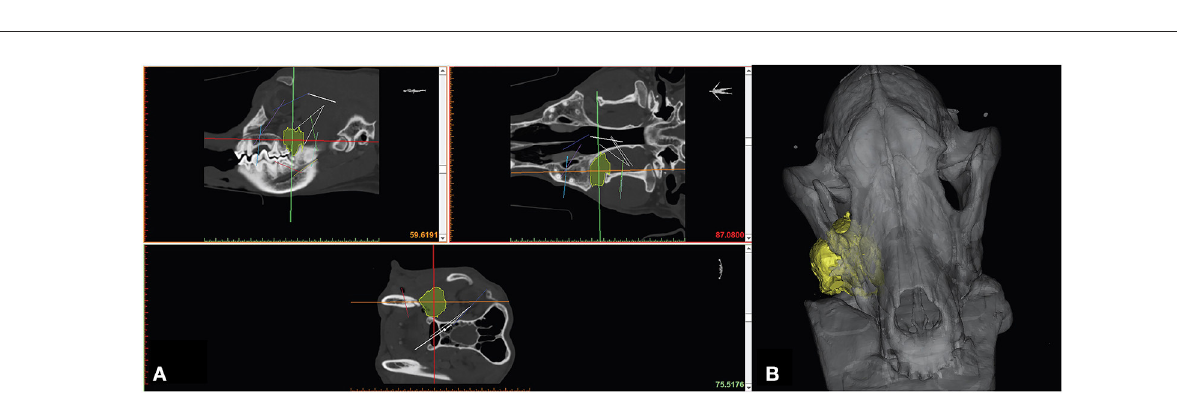
FIGURE3 Manual segmentation of soft tissue neoplasm (A) with resultant 3D computer model (B)